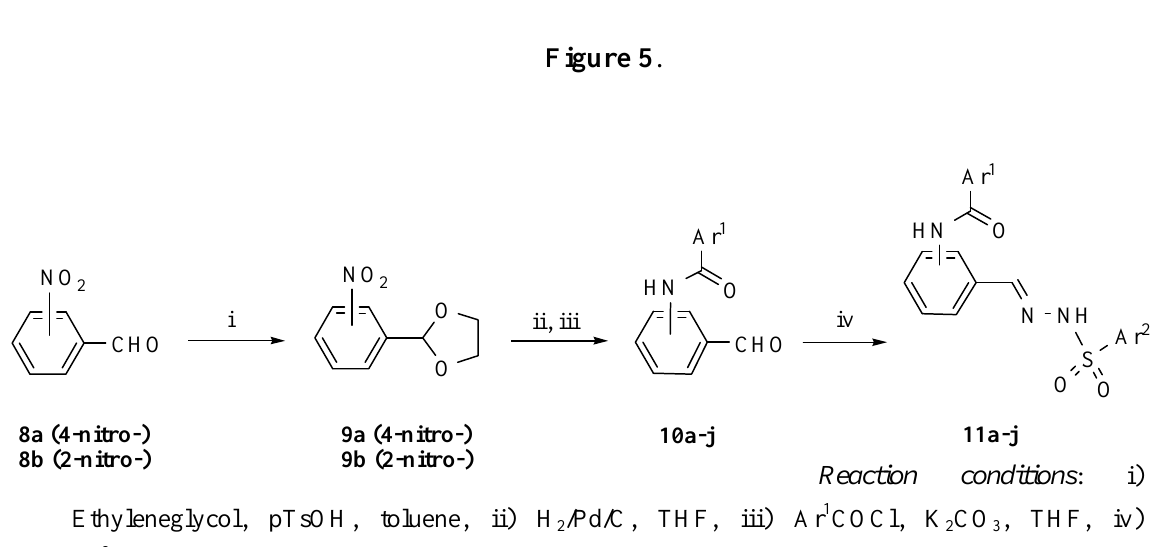
Reaction conditions : i) CO , THF, iv) 2 3